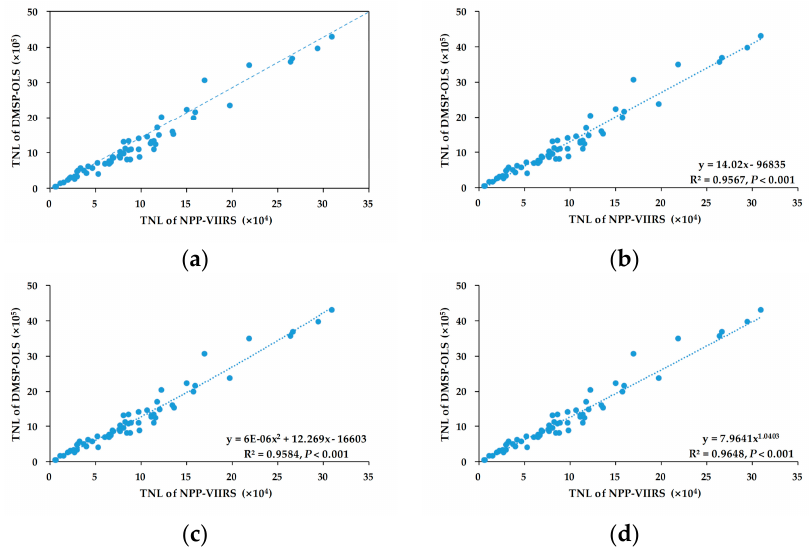
Figure 1. Correlation between the TNL from the DMSP-OLS data and NPP-VIIRS data in provincial units from 2012 to 2013: ( a ) the scatter diagram; ( b ) the linear model; ( c ) the quadratic polynomial model; ( d ) the power function model.